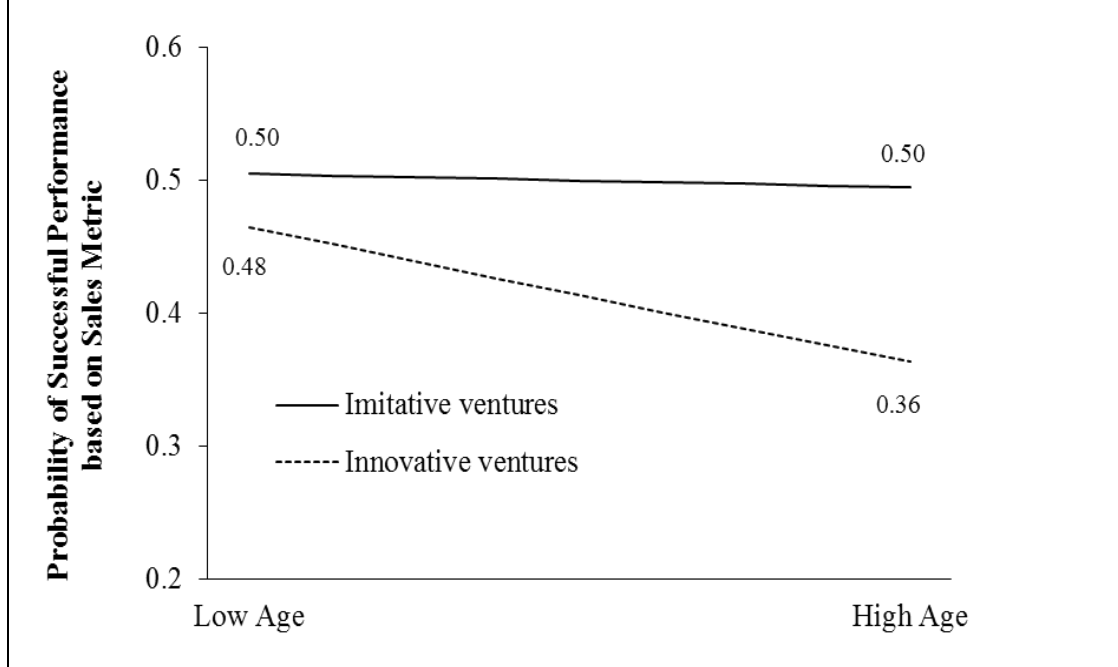
Figure 2. Moderating effect of venture innovativeness on the relationship between entrepreneur age and